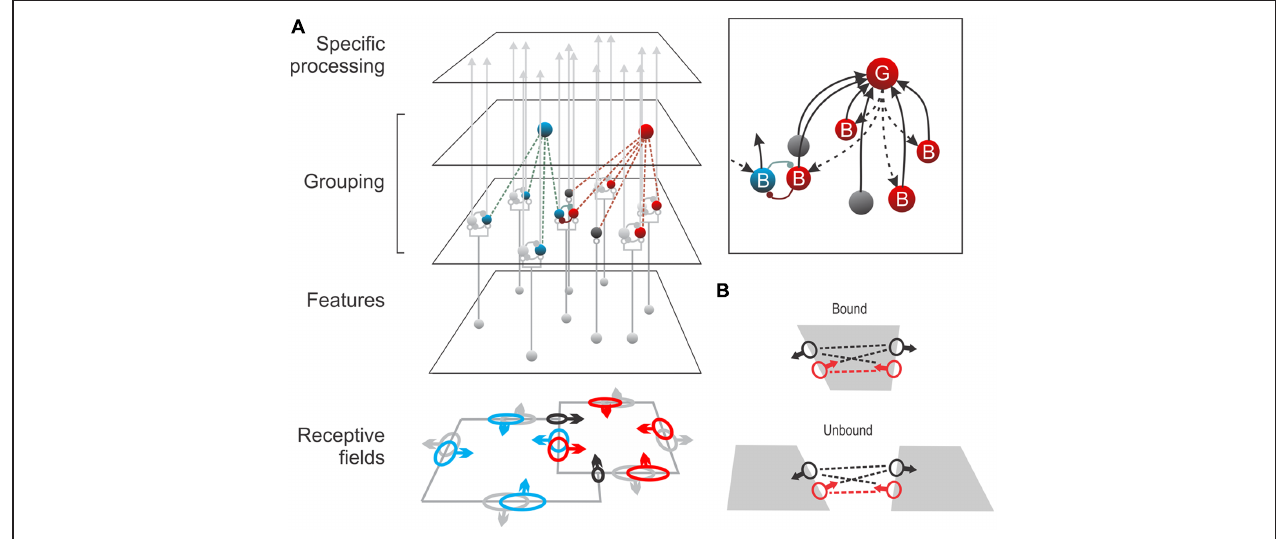
FIGURE 5 | A neural grouping model. (A) Edge-selective neurons at the Feature level activate two populations of border ownership neurons ( B -cells), one for each side of the edge. These neurons send signals to specific processing areas such as inferotemporal cortex, but they have also collateral projections to ‘ Grouping cells’ ( G -cells) which sum their signals, collecting edge signals in co-circular configuration. G -cells, by feedback, enhance the responses of the same B -cells ( Inset, dashed arrows ). Each B -cell is exclusively connected to G -cells on one side; thus, the enhancement makes the B -cell border ownership selective for that side. This is indicated by arrows on the receptive fields of the corresponding color. G -cells also sum responses of end-stopped cells ( black ) signaling local occlusion features like T-junctions which are indicators of border ownership. Assuming that top-down attention targets the G -cells, the model also provides a parsimonious explanation of object-based attention. (B) The model predicts that two B -cells that are connected to the same G -cell ( red dashed line ) will exhibit increased synchrony of firing when both are stimulated by the same object ( bound ) compared to activation by different objects ( unbound ), whereas B -cells that do not share common G -cells ( black dashed lines ) will show no increased synchrony. A recent study confirmed exactly these predictions (Martin and von der Heydt, 2015). (Modified from Craft et al.,